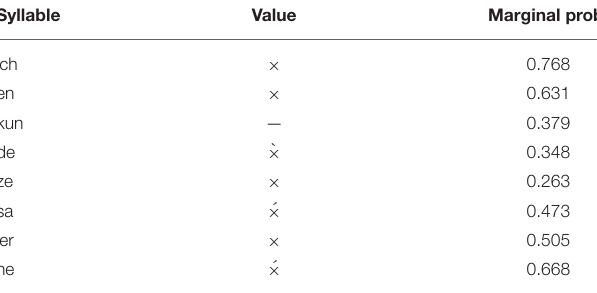
TABLE 9 | Example (9), average probability 0.504.